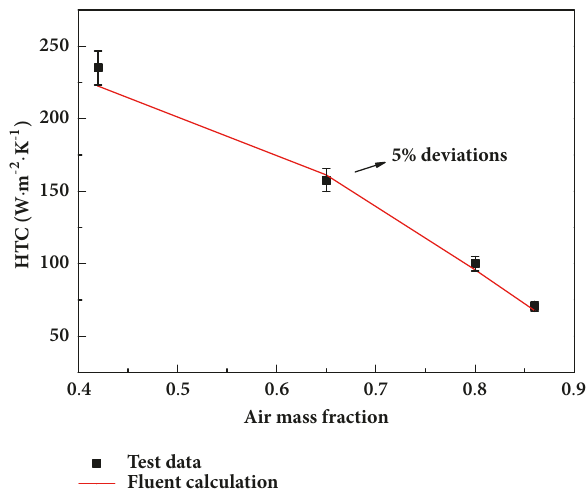
Figure 5: Comparison of simulation results with the scaled AP600 containment test data.